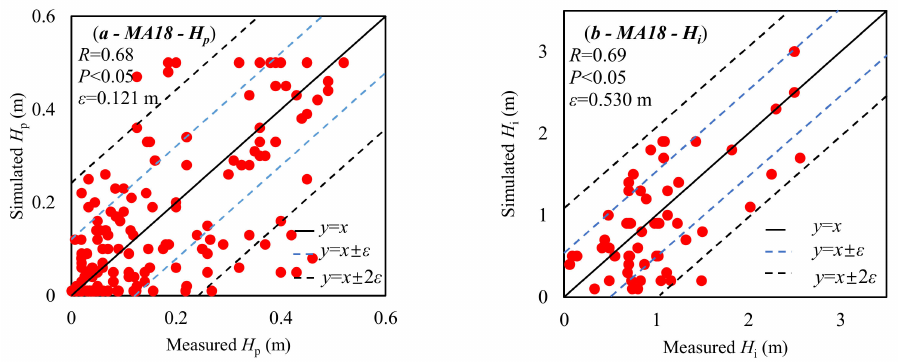
Figure 7. Panel ( a ) is the retrievals of H p and panel ( b ) is the retrieval of H i for the MA18 algorithm under overcast sky